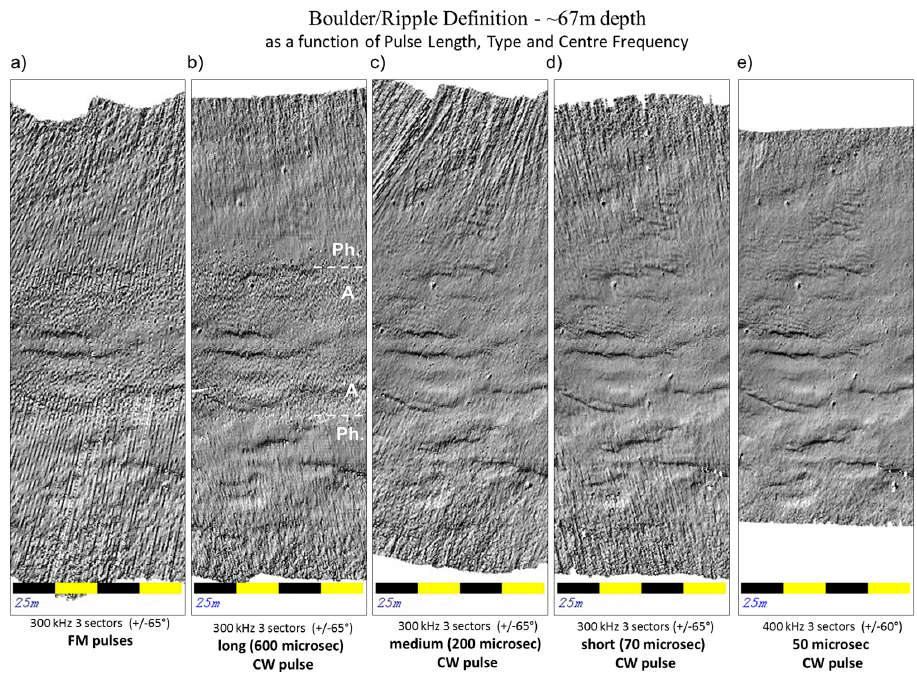
Figure 8. Identical seafloor (~67 m depth) viewed using different available sonar settings. Vessel steaming from left to right. From left to right they are ( a ) FM pulse—note drop to single swath apparent as across-track ribbing; ( b ) 0.6 ms CW, with dual-swath so ribbing removed, but note high noise at amplitude (A)-phase (Ph.) transition; ( c ) 0.2 ms CW, improved and narrower amplitude to phase transition, first resolution of the secondary dune population; ( d ) 0.07 ms CW, better view of the secondary dunes, but sensitive to noise in outer swath; ( e ) switching center frequency upward to reduce beamwidth, best view of geomorphology, but with reduced swath width.